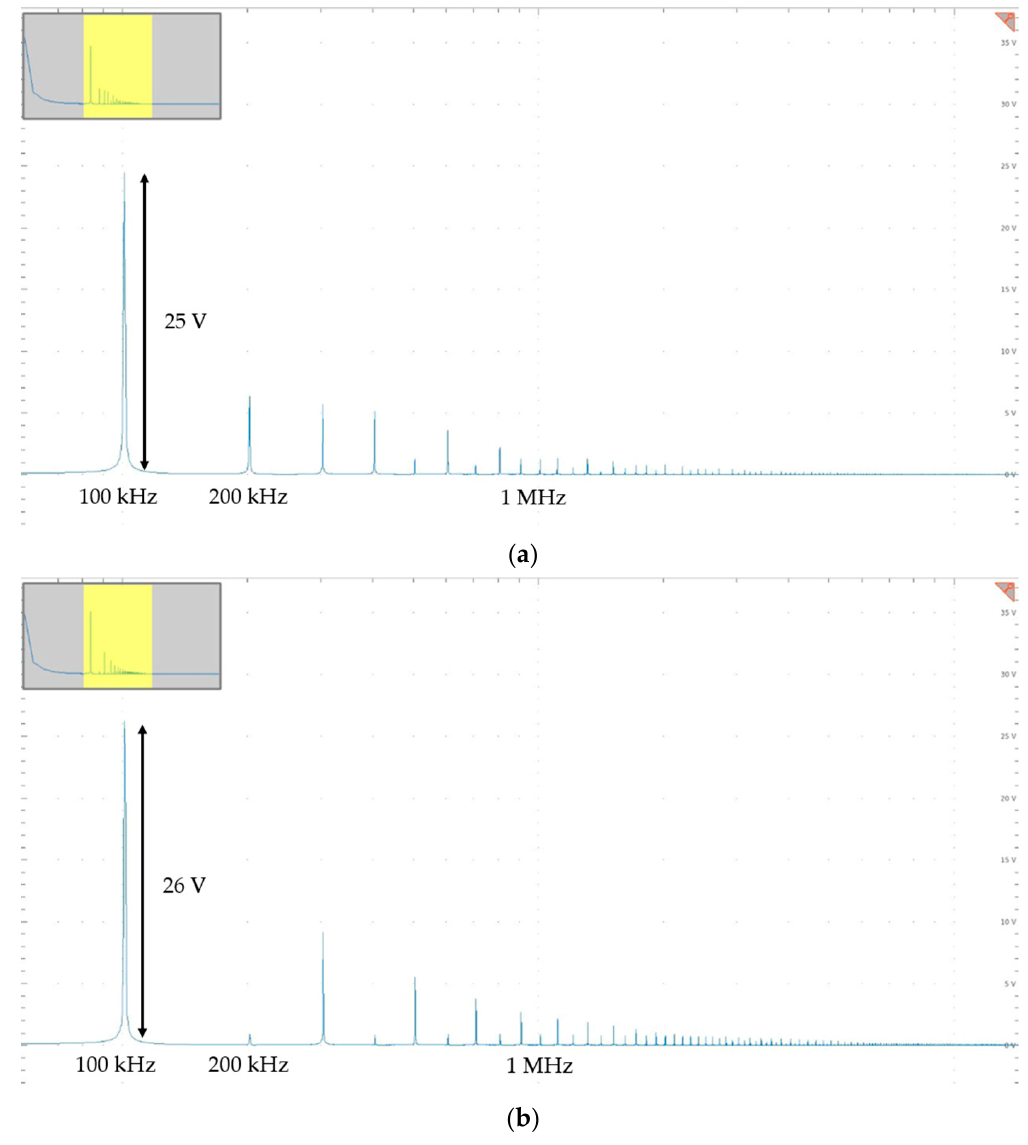
Figure 11. Drain voltage FFT at 100 kHz switching frequency: ( a ) with gate resistance; ( b ) w/o gate resistance. Table 2. Drain voltage FFT data at 100 kHz switching frequency and 60 V supply voltage. Peak